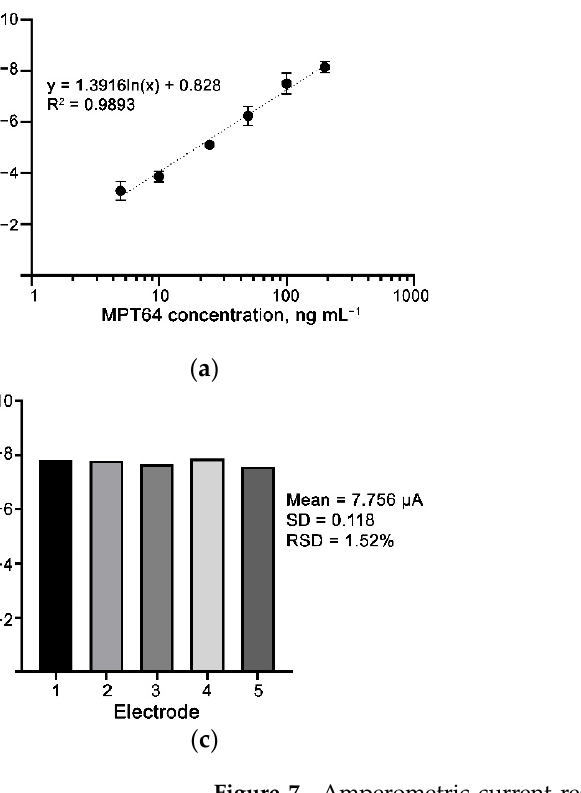
Figure 7. Amperometric current response of the aptasensor incubated with a series of MPT64 protein concentrations in ( a ) buffer system and ( d ) spiked serum sample. ( b ) Selectivity study of the aptasensor. Statistical analysis was performed using the post hoc Tukey test. Data are presented as the mean of triplicate ± SD, **** denotes p < 0.0001. ( c ) Reproducibility of the developed aptasensor incubated with 50 ng mL − 1 of MPT64 antigen. Table 1. Comparison of the analytical performance of developed aptasensor with the previously developed electrochemical biosensor towards TB